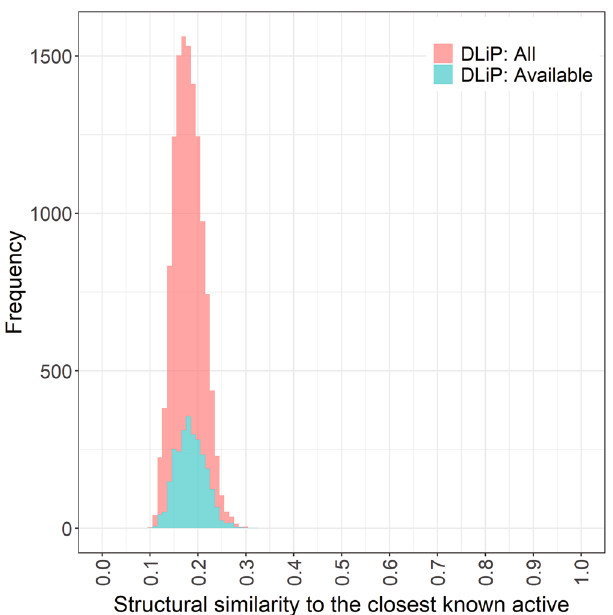
Figure 2. Distribution of structural similarities (Tanimoto similarities of FCFP_6) of all (N = 12,593, light red) compounds of the DLiP library and their available subset in this study (N = 2,684, cyan) to their closest known Keap1/Nrf2 PPI inhibitors in the databases.